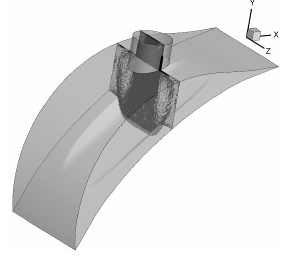
Figure 5. Location of cross section.